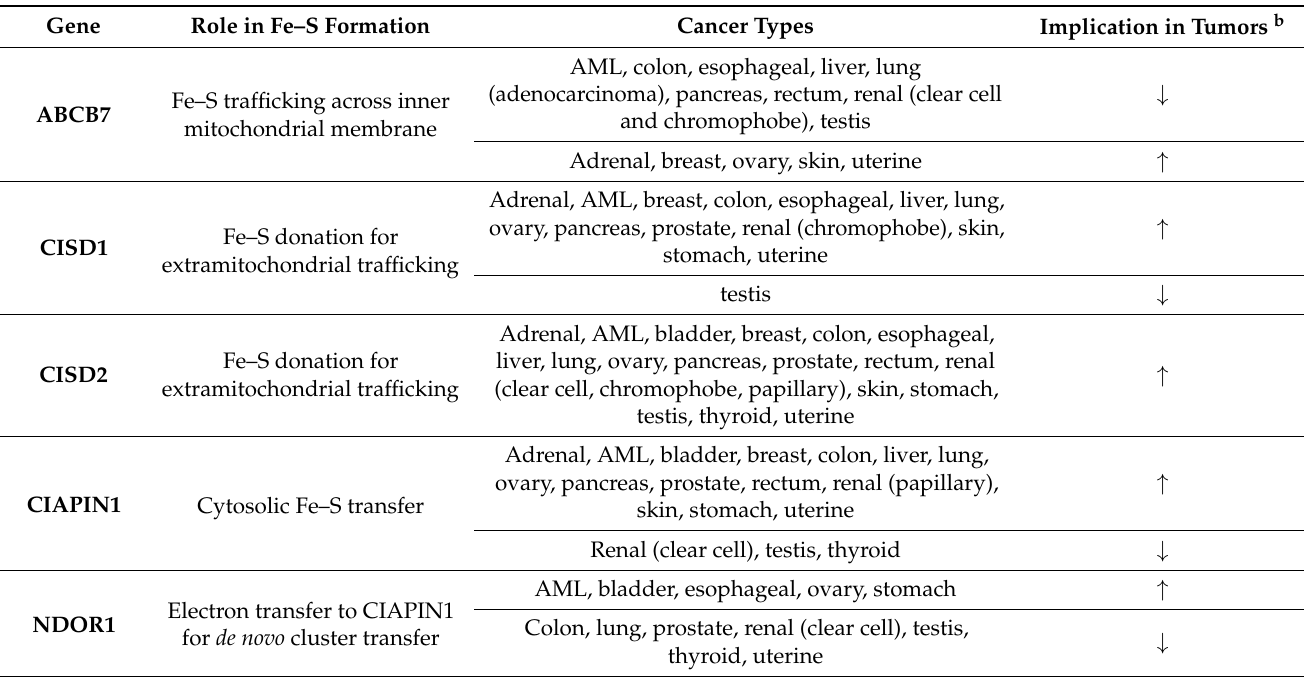
Table 2. [4Fe-4S] biogenesis in tumor tissues relative to their normal tissue counterparts a . Gene Role in Fe–S